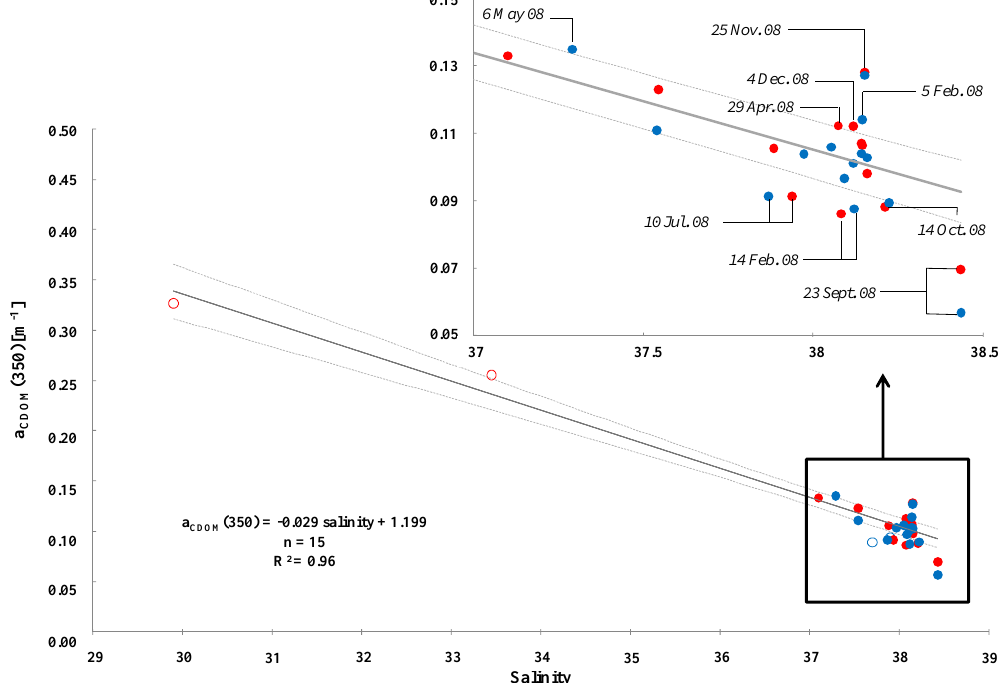
Fig. 3. Relationship between salinity and CDOM absorption at 350nm (in m − 1 ) determined at SOFCOM station at 2m (red circle, n = 13) and 5m (blue circle, n = 14) depths. Data from Rhˆone Estuary stations collected in May 2008 during CHACCRA cruise at 2m (red open circle, n = 2) and 5m (blue open circle, n = 2) were also plotted. The mixing line (black line) with its confidence interval at 95% (dashed line) was established using all SOFCOM station data at 2m depth ( n = 13) plus Rhˆone Estuary stations (CHACCRA cruise data) at 2m depth as well ( n = 2).